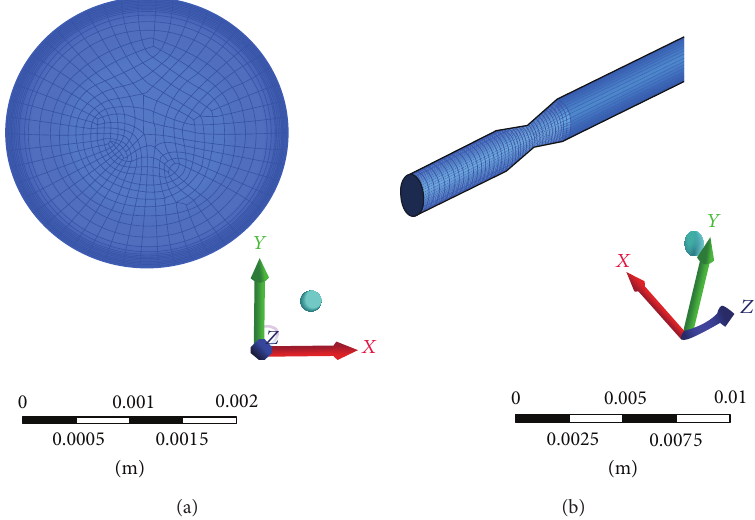
Figure 3: Computational mesh used for numerical study in the triangular model.